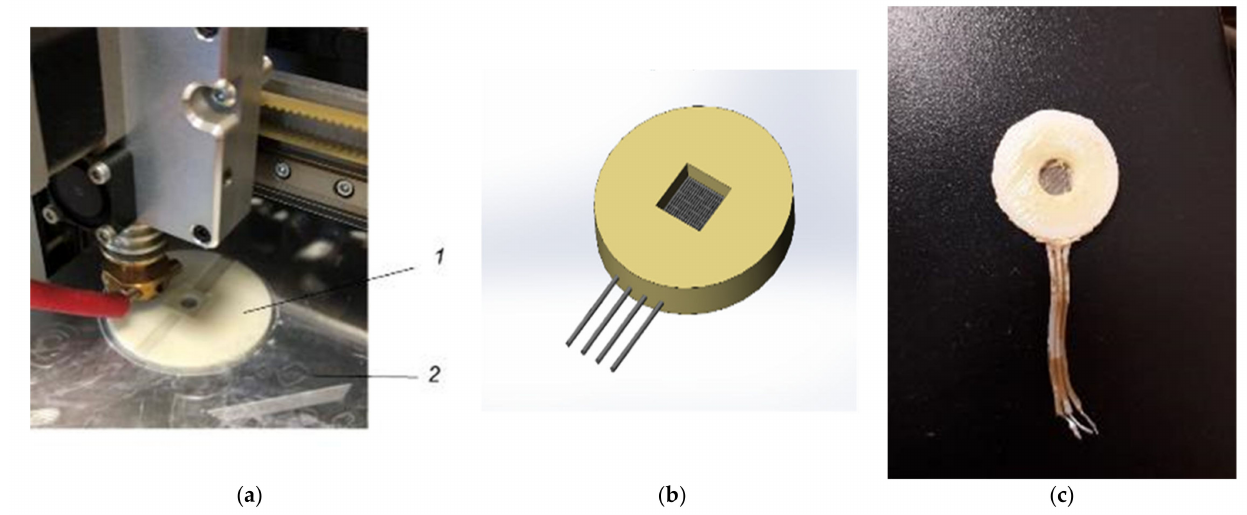
Figure 4. Manufacturing of the holder for the conversion element ( a ) of the 3D body; ( b ) a model of the electrochemical conversion element; ( c ) the finished conversion element in the